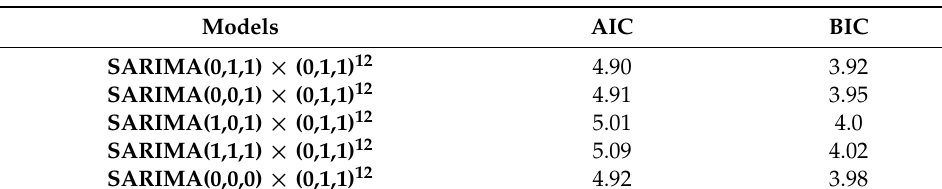
Table 6. AIC and BIC values for optimal model selection.